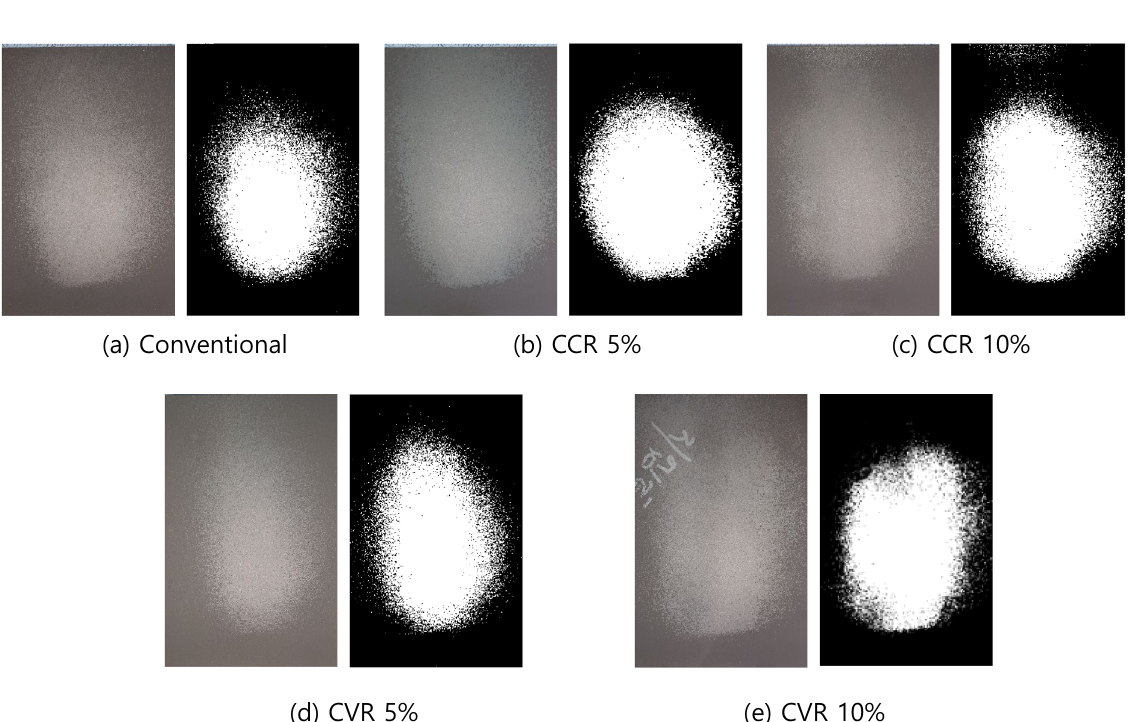
Figure 16. Shot ball marks for conventional, concave, and convex